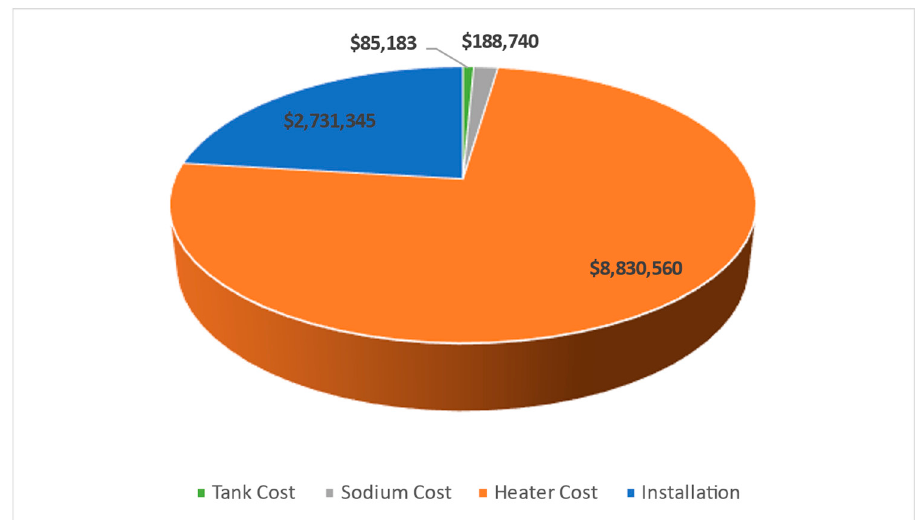
Figure 6. Cost Breakdown of the Liquid Sodium Charge Tank.